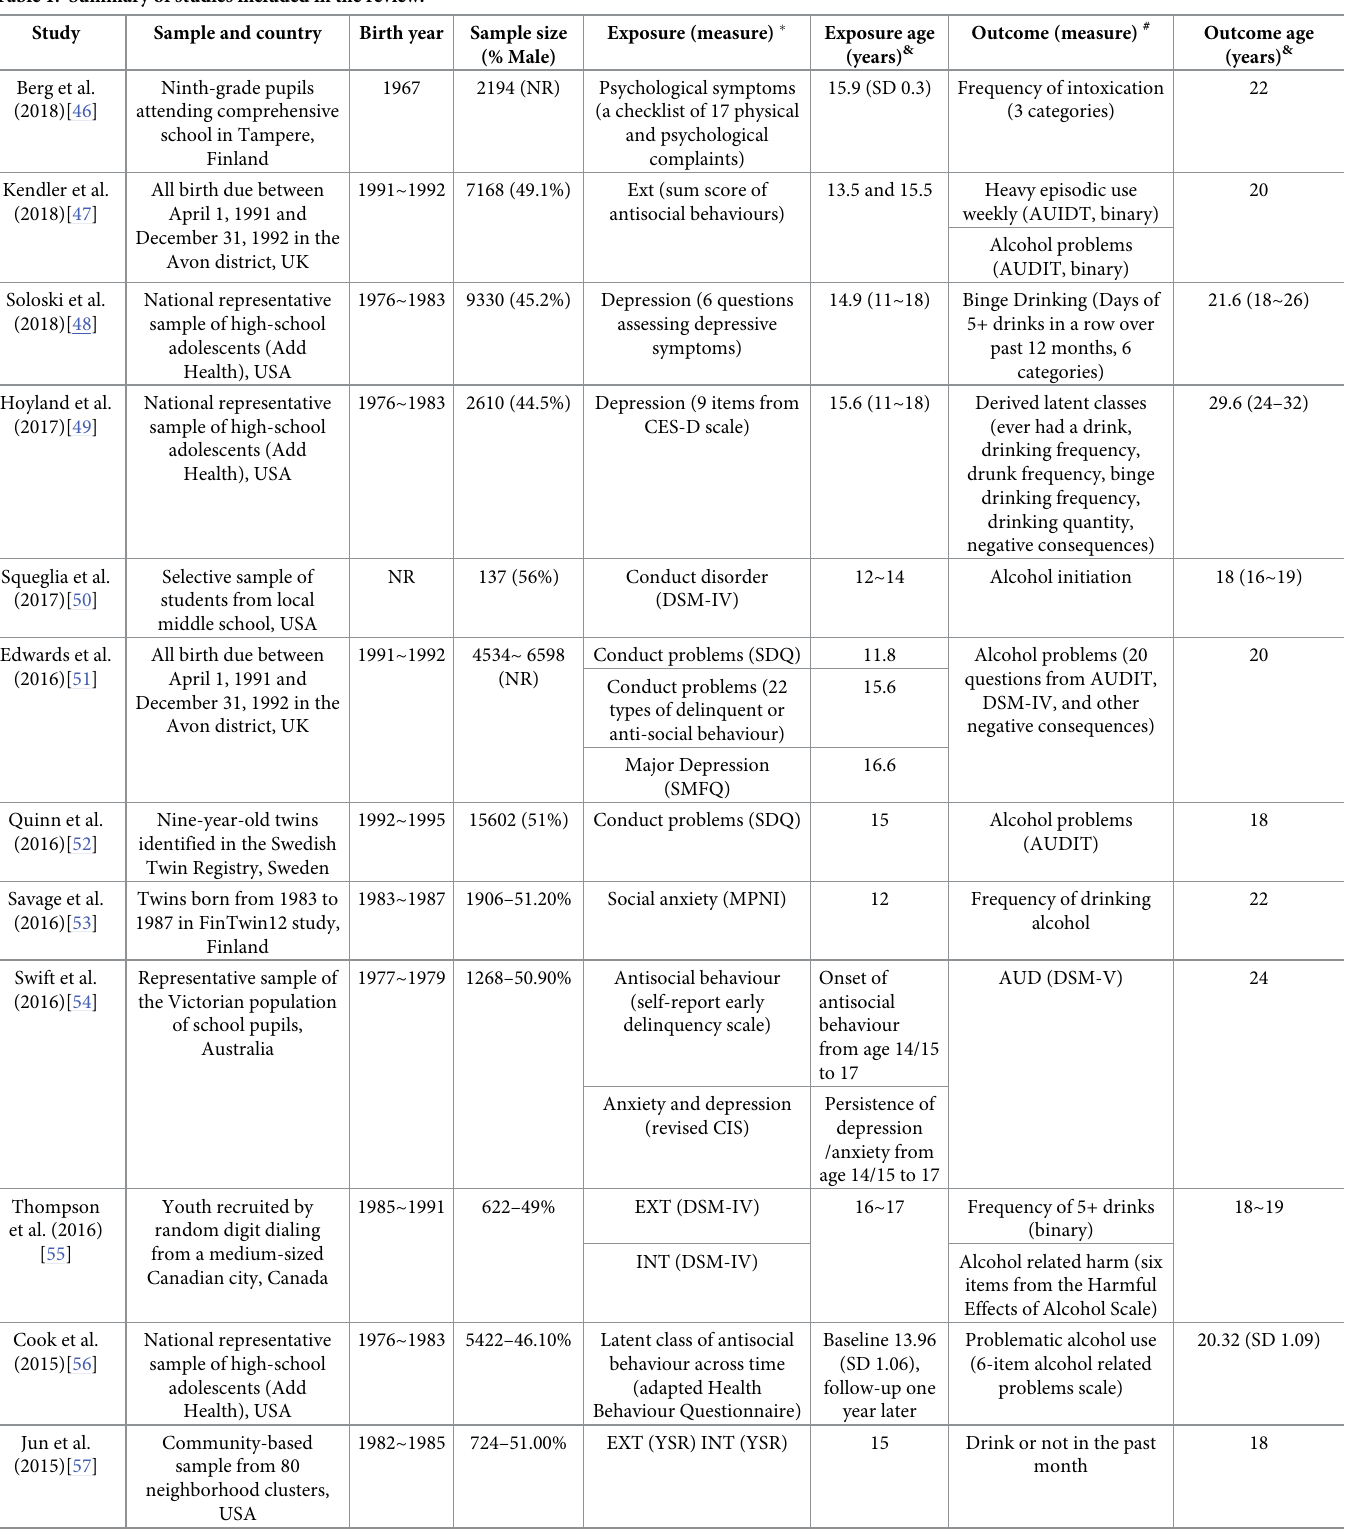
Table 1. Summary of studies included in the